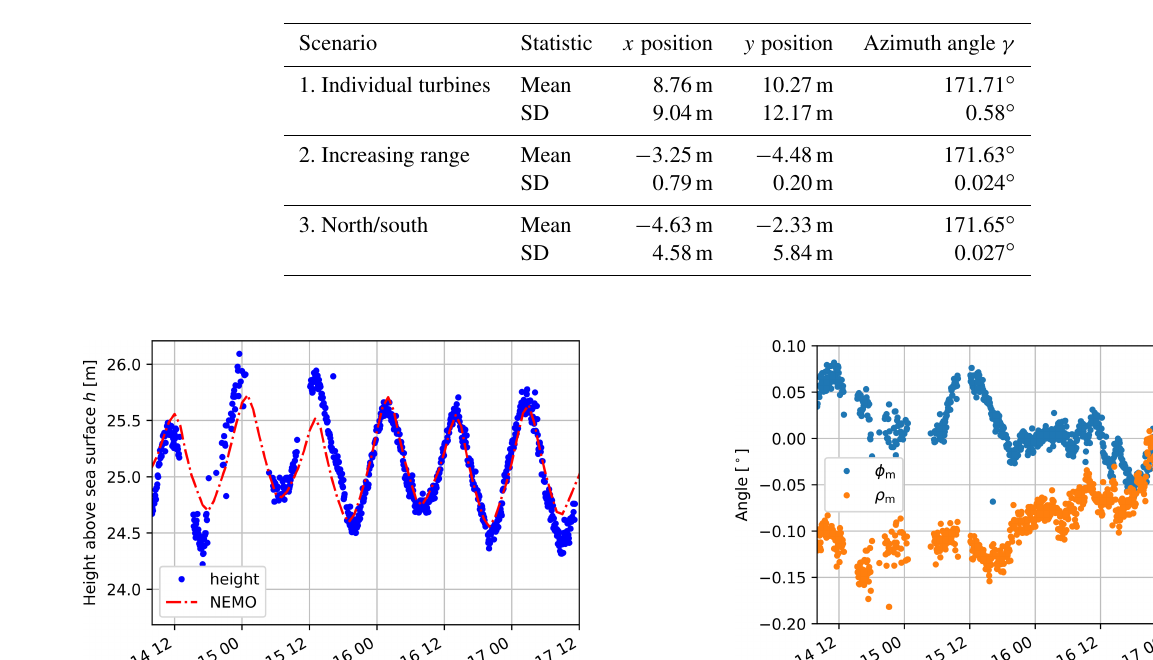
Table 1. Results of the HT for three scenarios.